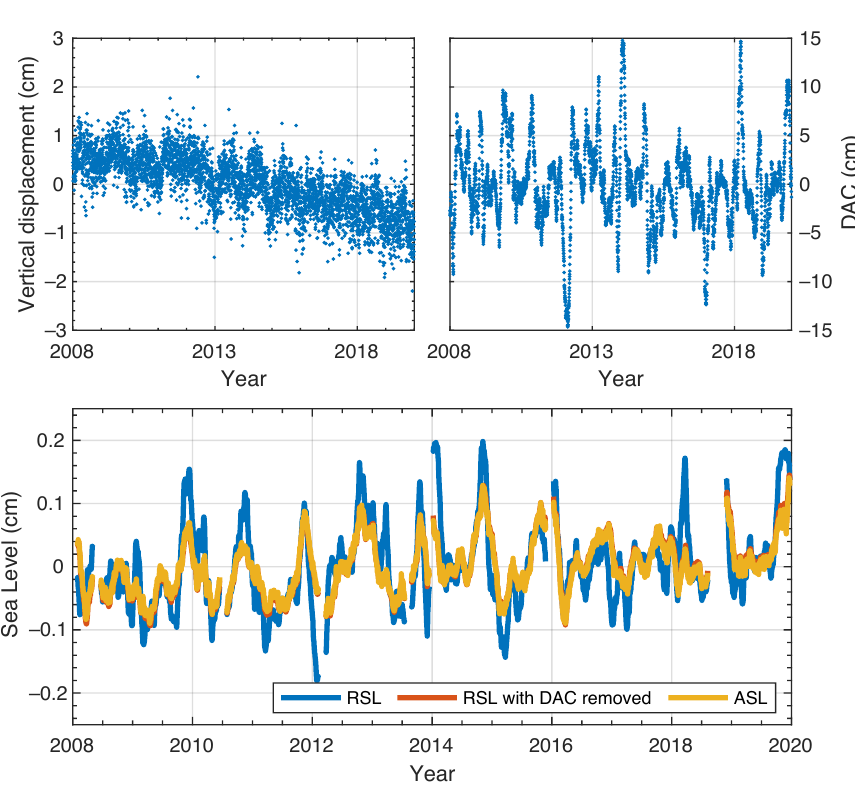
Figure A4. Same as Figure 5, but for SC02.